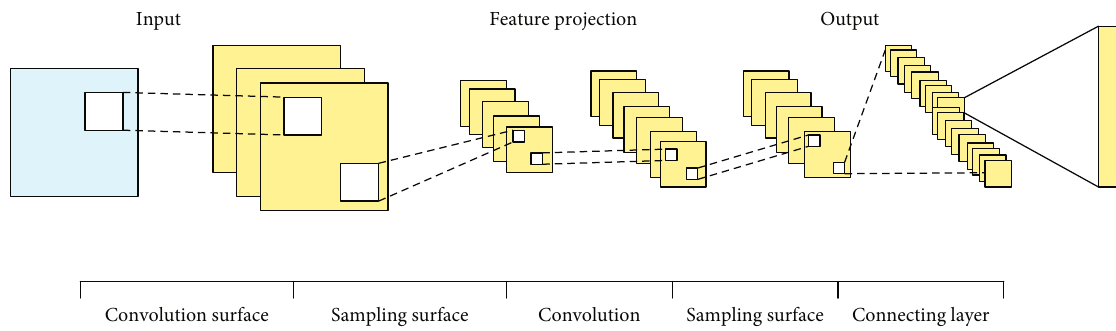
Figure 5: Construction of a convolutional neural network.